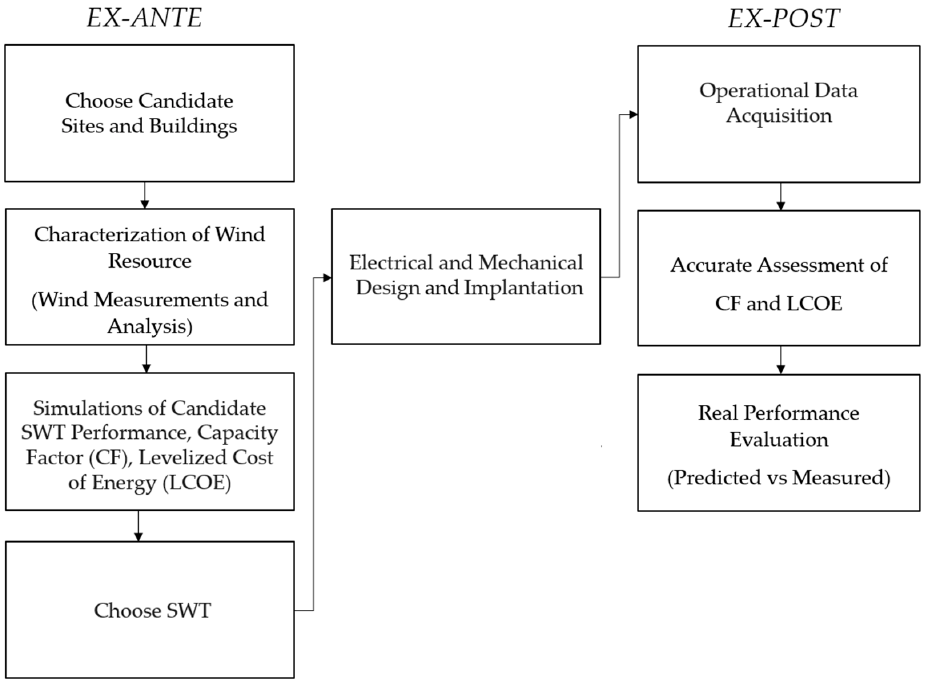
Figure 3. Schematic diagram of the methodology used for wind resource assessment and economics. Source: our elaboration.